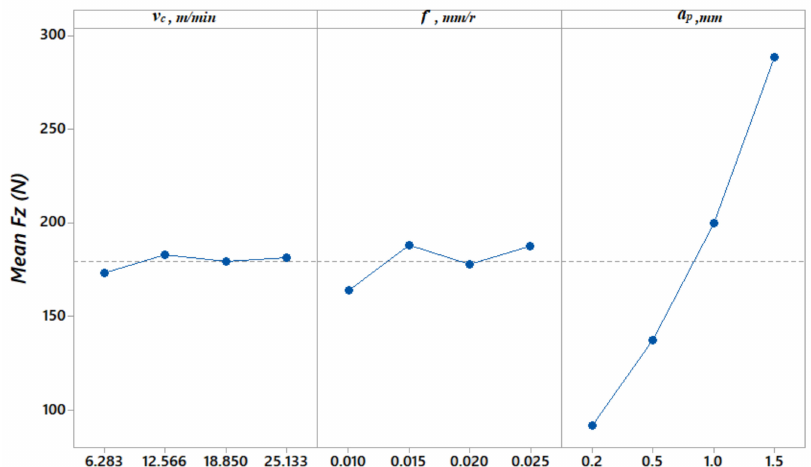
Figure 4. Main e ff ect plots for F z cutting force.